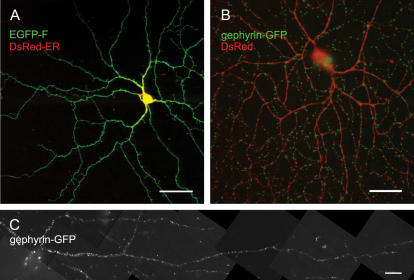
Expression of markers for subcellular structures in retinal ganglion cells.(A) Single confocal image plane of a large ON ganglion cell transfected with expression plasmids for EGFP-F (labeling the cell membrane) and DsRed2-ER (labeling the endoplasmic reticulum.) Scale bar, 50 µm. (B) Volume reconstruction of a confocal image stack of a large ganglion cell transfected with the cell-filling marker HcRed and a marker for postsynaptic densities of inhibitory synapses, gephyrin-GFP (green). Scale bar, 50 µm. (C) A single dendrite of an OFF alpha ganglion cell transfected with gephyrin-GFP. Note the high density of puncta particularly on the proximal dendrites. Scale bar, 20 µm.